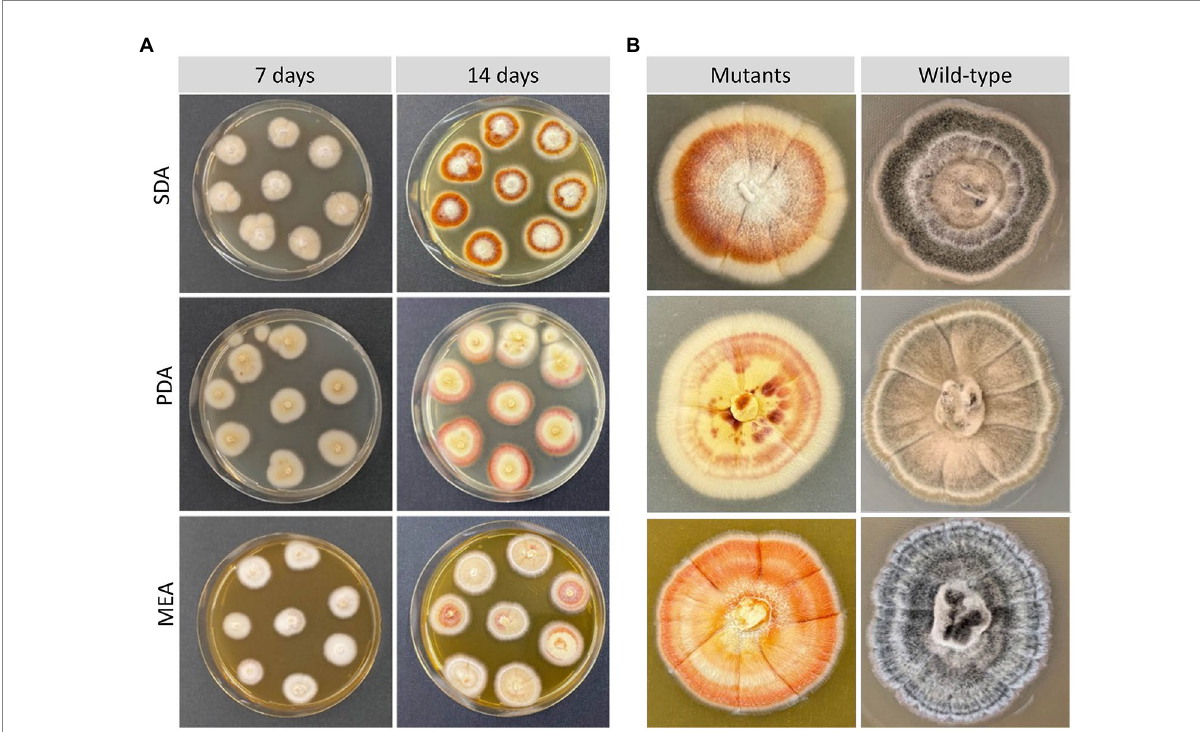
FIGURE 3 Morphological characteristics of Lophiotrema sp. F6932 CRISPR/Cas9-induced mutants. (A) Morphology of the deletion mutants after 7 and 14 days of growth in SDA, PDA, and MEA media; (B) close-up view comparison of the colony morphology of the deletion mutants and the wild-type strain after 21 days of growth in SDB, PDA, and MEA